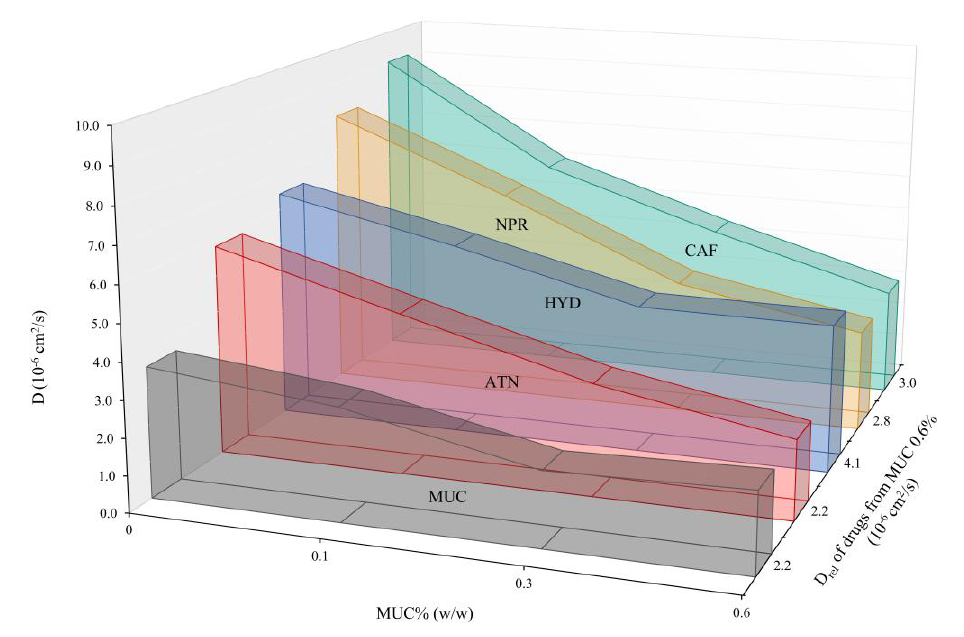
Figure 3. Relation between drug diffusivities (D) and the different mucin concentrations (MUC 0.0, 0.1, 0.3, and 0.6% w/w ) for ATN, CAF, HYD, NPR, and MUC. Data reported represents the average of two parallel experiments (variation below 5% and fitting error below 1%).